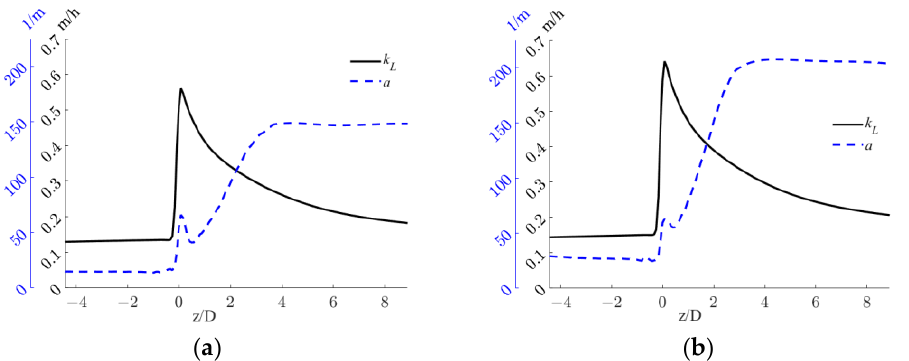
Figure 7. Axial profiles of k L and a , for the operative conditions considered: ( a ) Q L = 25 m 3 /h and Q G = 3.75 L/min; ( b ) Q L = 30 m 3 /h and Q G = 7.5 L/min. The initial and final part of the pipe are omitted to improve readability.